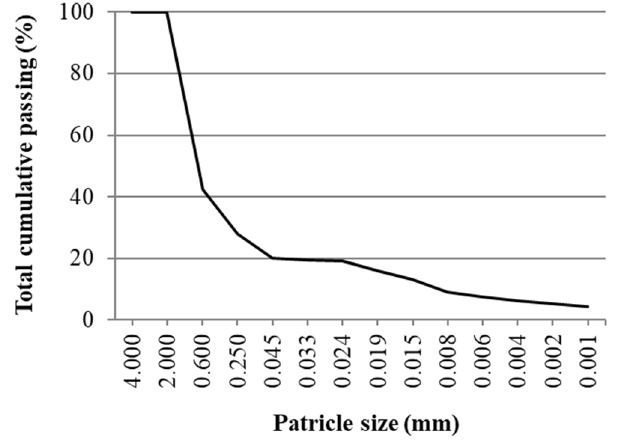
Figure 2. Soil particle size distribution curve.